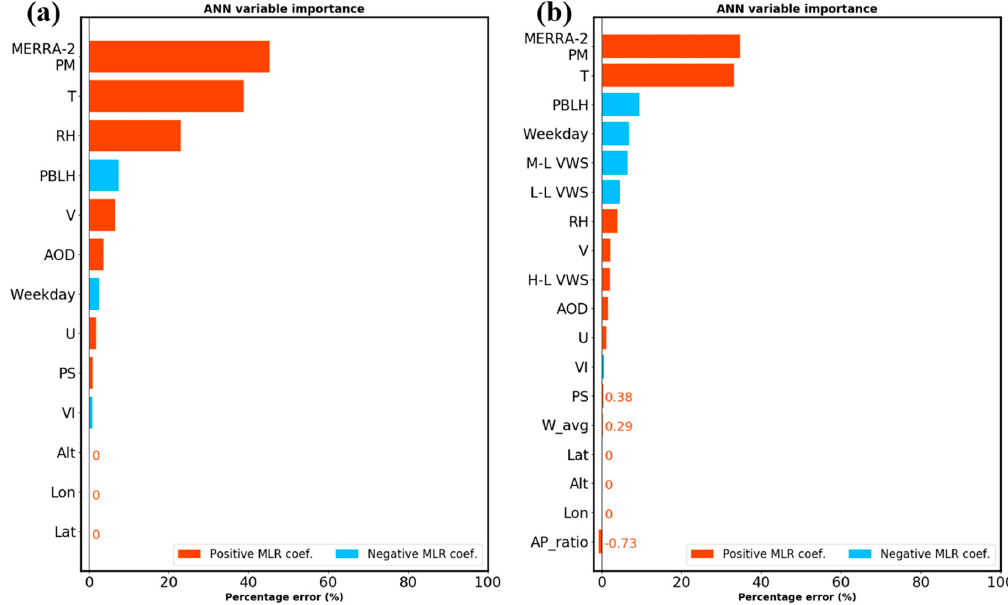
Figure 6. Variable importance of ( a ) set 1 and ( b ) set 2 models at Rochester site. Values indicate the permutation importance estimated from the ANN models, and colors indicate the signs of regression coefficients in the MLR models.